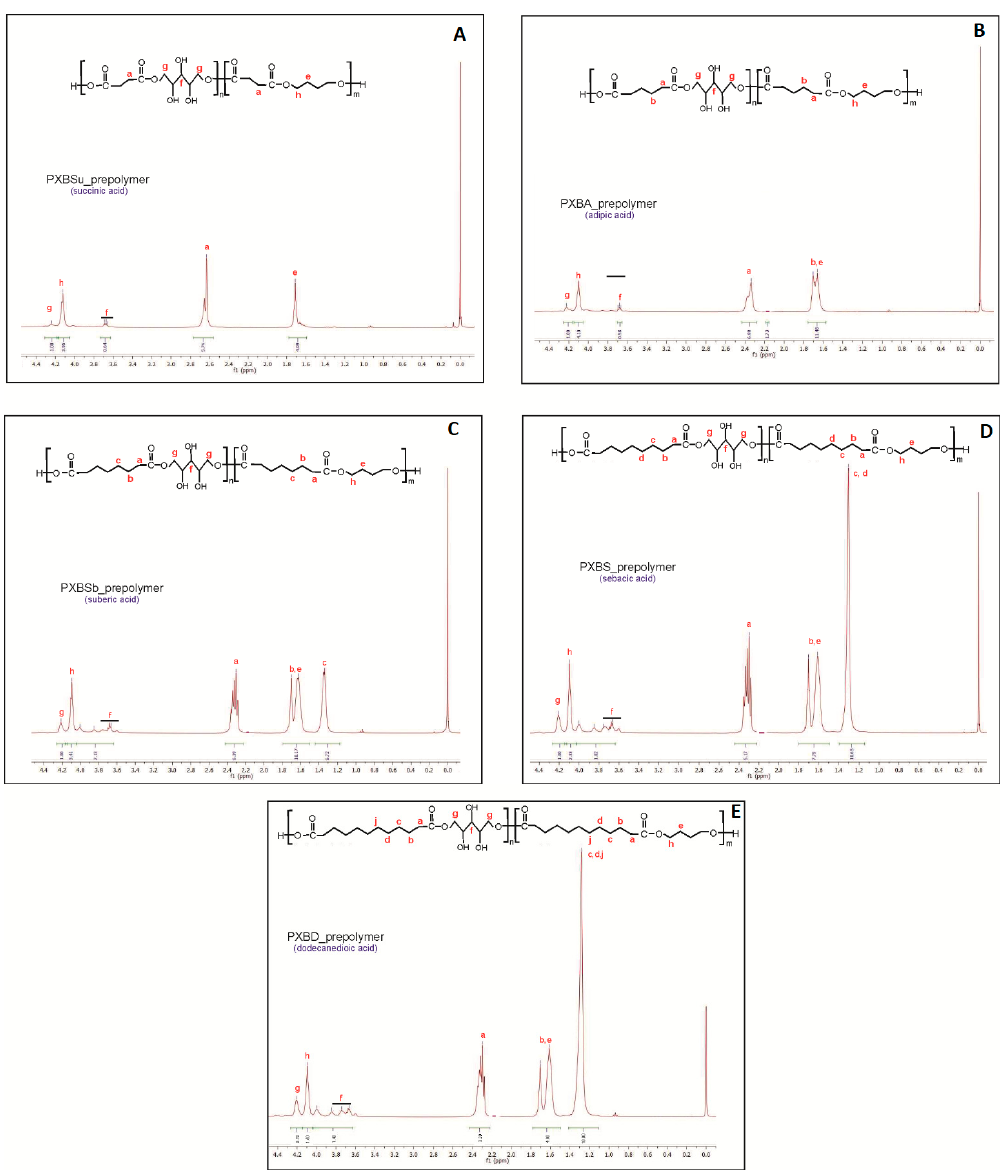
Figure 2. 1 H NMR of PXBSu(A), PXBA(B), PXBSb(C), PXBS(D), PXBD(E) prepolymers.